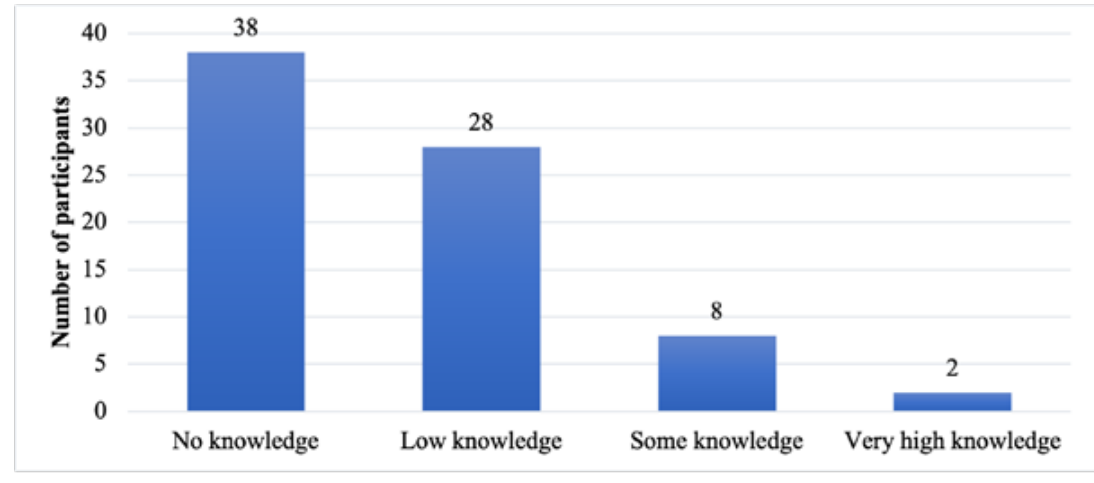
Figure 2. Knowledge levels on the effects of the MC & female hormones on the body